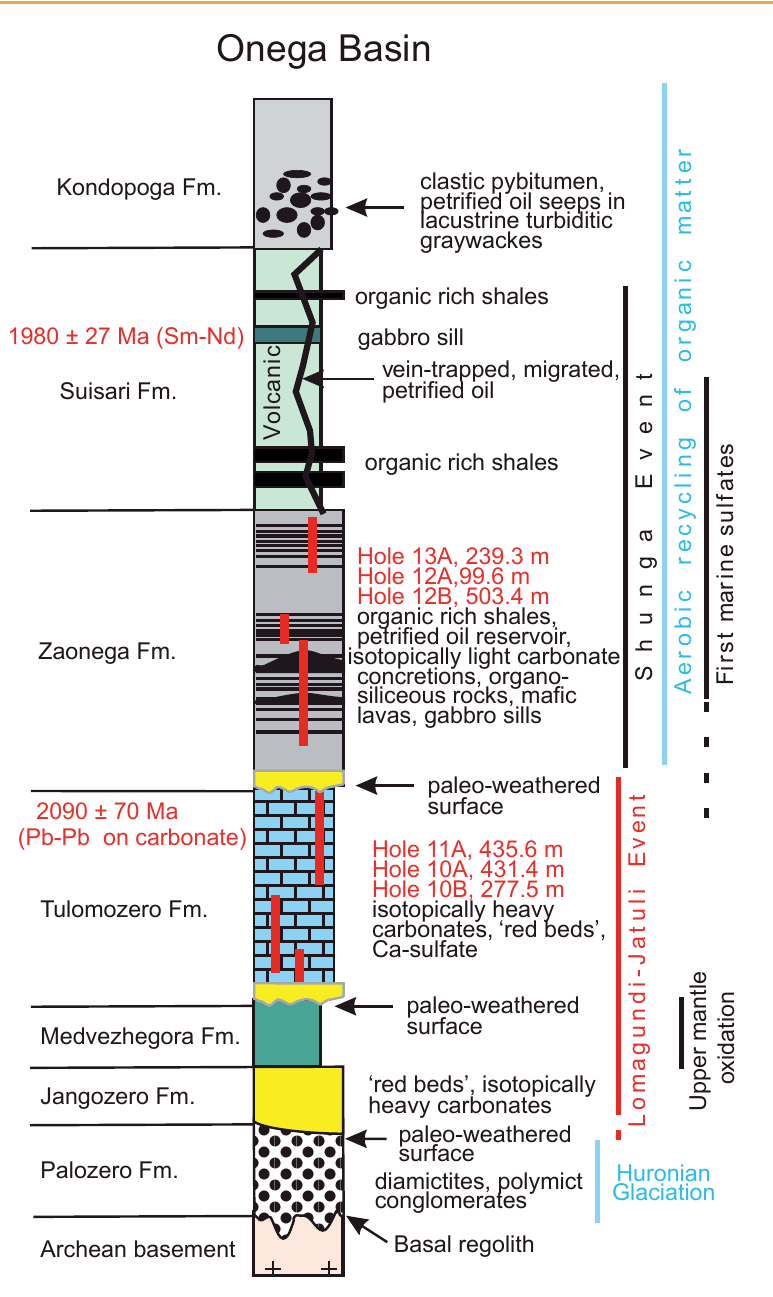
Figure 5. Composite (~5000-m-thick) and simplified Paleoproterozoic section for the Onega Basin linked to major paleoenvironmental events. Radiometric dates from bottom to top are from Ovchinnikova et al. (2007) and Pukhtel et al. (1992). Vertical red lines show the position of the drillholes. The number of the drillhole and its depth are shown in red-face letters; this is followed by text briefly describing rock lithologies intersected by the